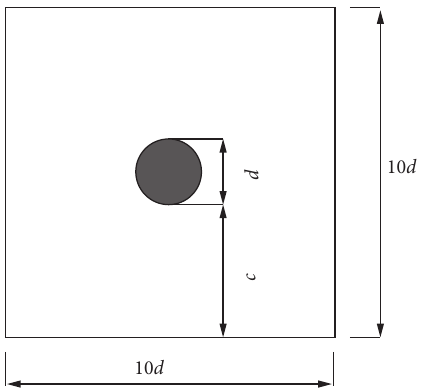
Figure 4: Elastomechanical analysis of concrete